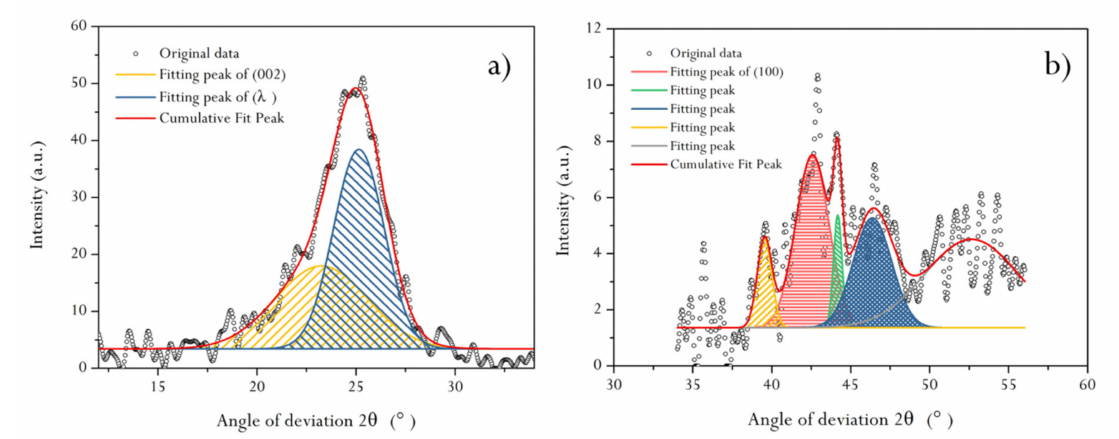
Figure 5. Peak fitting results of the demineralized HNC in ( 002 ) ( a ) and ( 100 ) ( b )